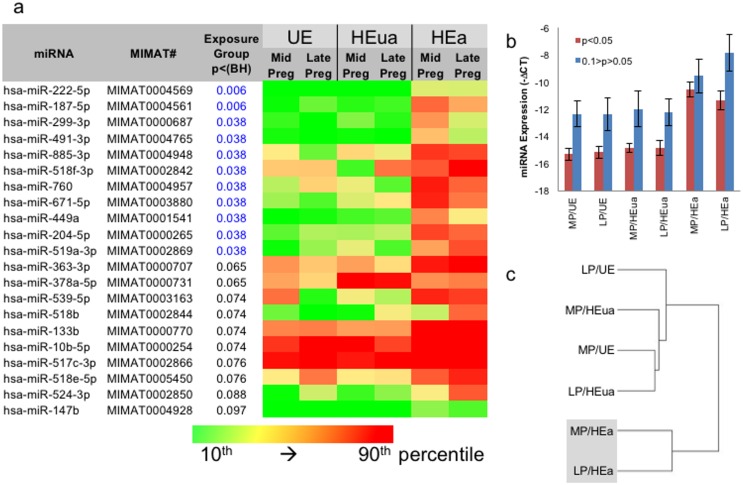
ANOVA model identifies maternal plasma miRNAs elevated specifically in the HEa group.(a) List of miRNAs that pass the FDR-corrected criterion of P < 0.05. Color scale ranges from 10th (green) to 90th (red) percentile of expression. miRNA expression in the HEa group at both mid and late pregnancy was generally elevated compared to expression in all other groups (for additional detail, see S2 Fig). (b) Average expression of miRNAs that exceed P < 0.05 and P < 0.1 BH-corrected criteria. (c) Cluster analysis (with Euclidean distance and average linkage) of miRNAs that exceed the BH-corrected P < 0.1 criterion indicates that HEua and UE groups cluster together and are different from HEa groups at mid and late pregnancy. MP, mid-pregnancy; LP, late pregnancy; MIMAT#######, miRNA unique ID as in mirbase.org.